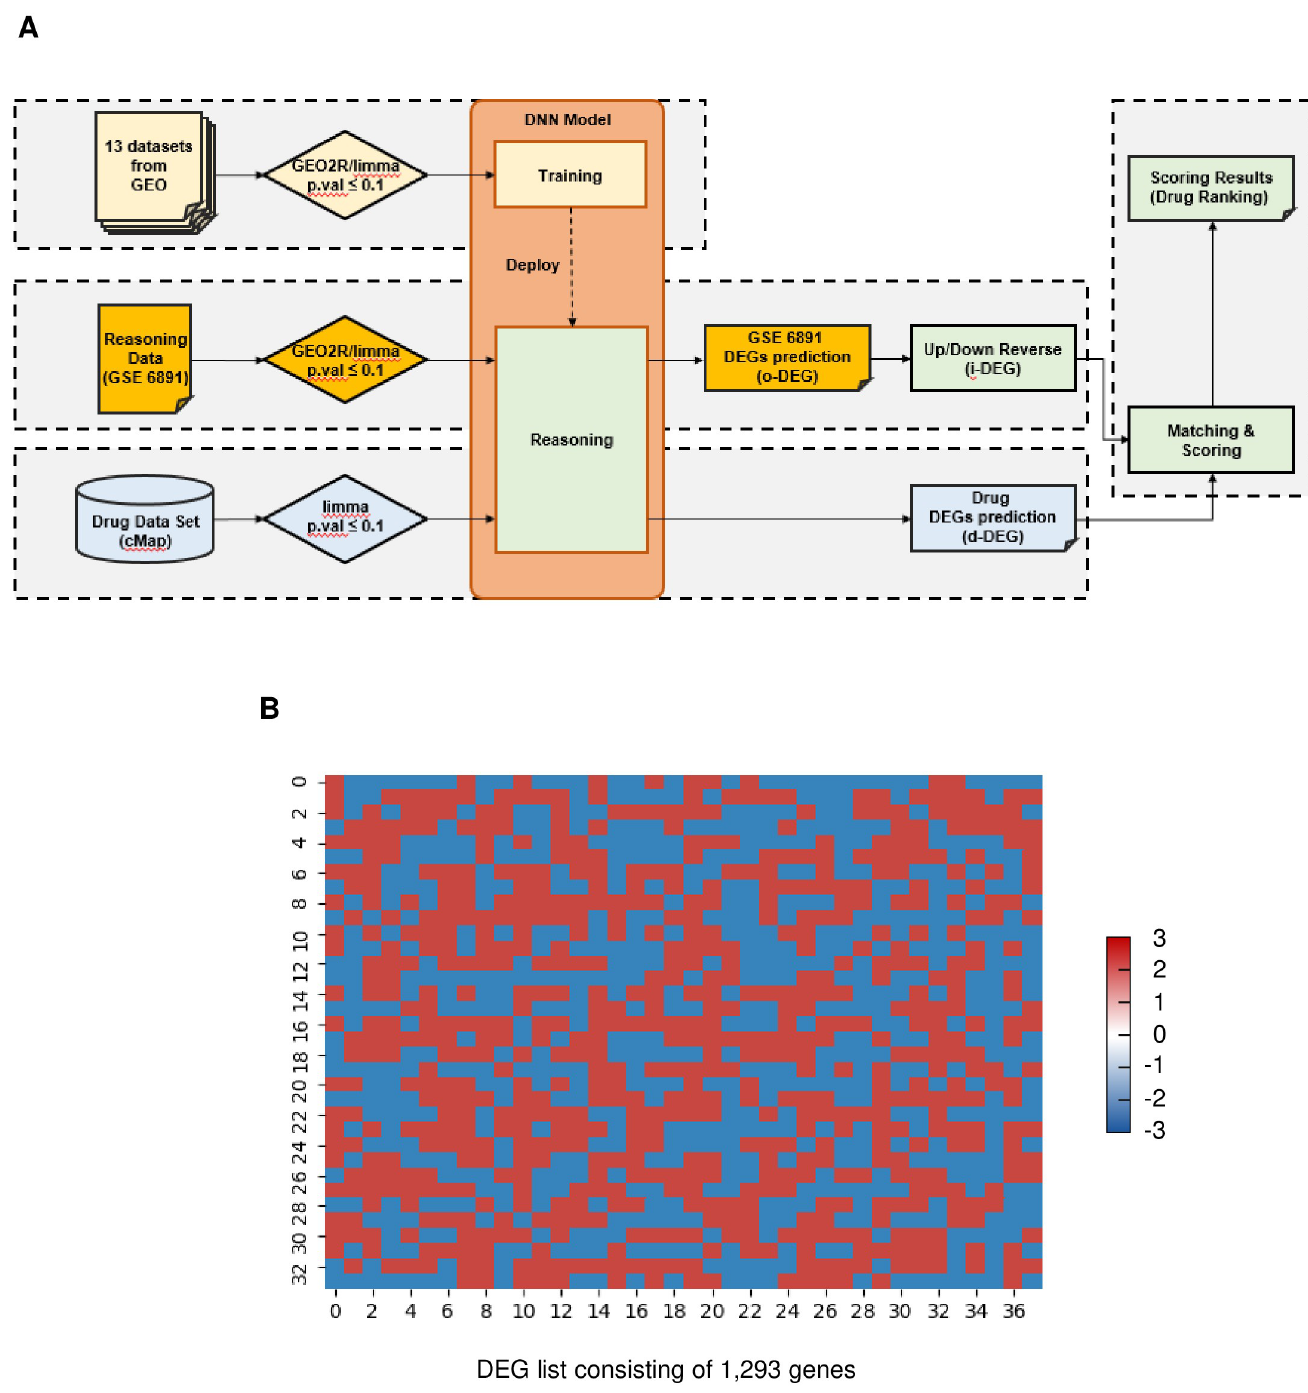
Fig 1. Original differentially expressed genes (o-DEGs) between normal and aged groups. (A) A schematic of training deep neural network (DNN) model with gene expression data from 13 datasets from GEO. DEGs pattern of an aged group (o-DEG) was built and transformed into i-DEG for matching with d-DEG. d-DEG was created with drug-induced gene expression data from the Connectivity Map. i-DEG and d-DEG are matched and scored to rank drugs. (B) A heatmap of up- regulated genes (marked in blue) and down-regulated genes (marked in red) in the aged group compared to the normal group. The total gene number in this pattern is